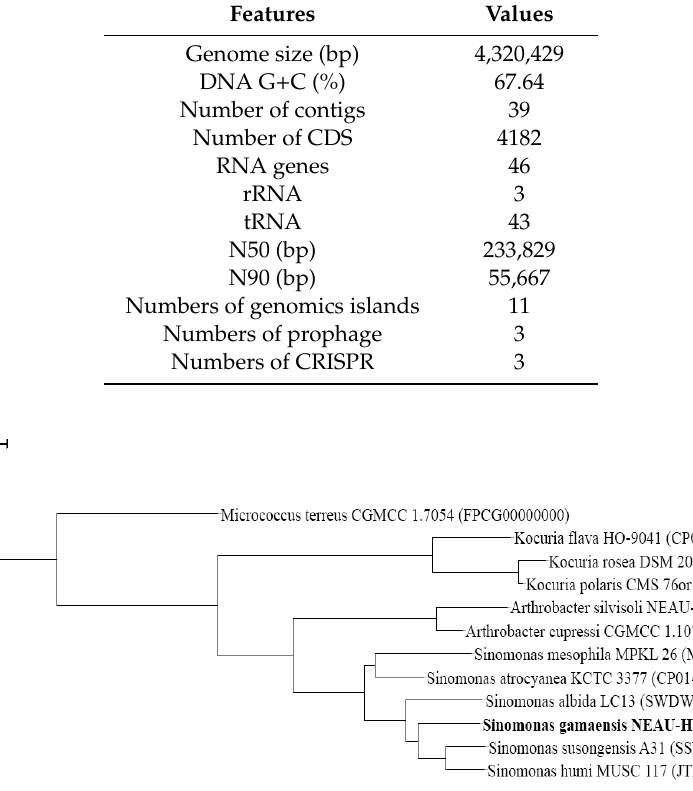
Figure 3. Neighbor joining tree showing the phylogenetic position of strain NEAU-HV1 T relative to closely related type strains based on the core genome. Table 3. The digital DNA–DNA hybridization (DDH) and average nucleotide identity (ANI) values between strain NEAU-HV1 T and the closely related members of the genus Sinomonas. Strains